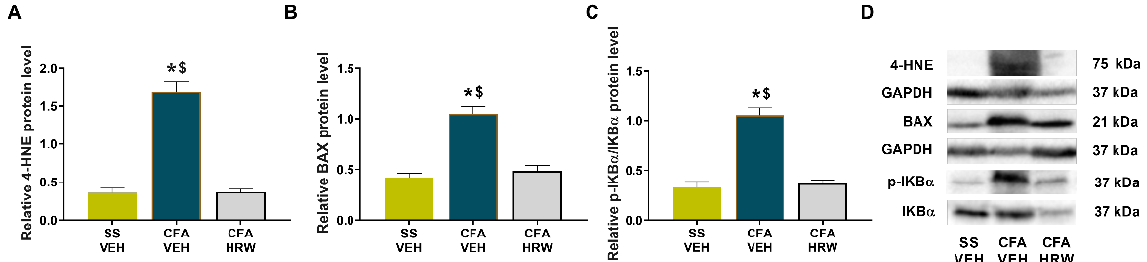
Figure 7. Effects of HRW on the expression of 4-HNE, BAX, and p- IKBα in the paw tissues of CFA - injected mice. The protein levels of 4-HNE ( A ), BAX ( B ), and p- IKBα ( C ) in the ipsilateral paws of CFA-injected mice treated with VEH or HRW are shown. SS-injected mice treated with VEH, used as controls, are also shown. Examples of blots for 4-HNE, BAX, and p- IKBα are displayed ( D ). 4- HNE and BAX are expressed relative to GAPDH levels, while p- IKBα is expressed relative to IKBα. In all graphics, * denotes significant differences vs. SS-injected mice plus VEH, and $ denotes signif- icant differences vs. CFA-injected animals plus HRW ( p < 0.05; one-way ANOVA and Student–New- man–Keuls test). Data are shown as the mean ± SEM; n = 3 samples.